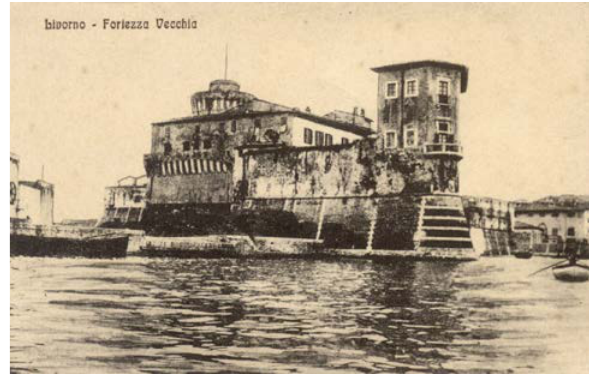
Figure 4: Archive image of the West side of Palazzo di Cosimo ( Collezione Pelosini , Courtesy Biblioteca Labronica F.D.